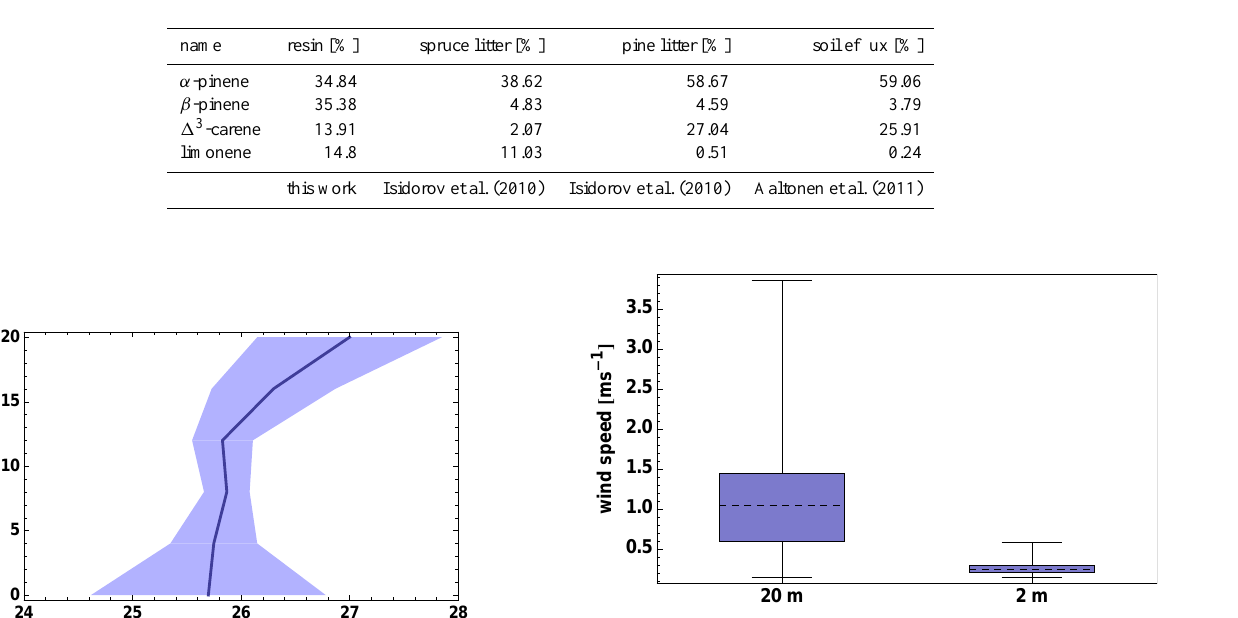
Table 4. Comparison of the relative contribution of monoterpenes from several possible sources near the forest floor. Resin samples have been taken in September 2010.